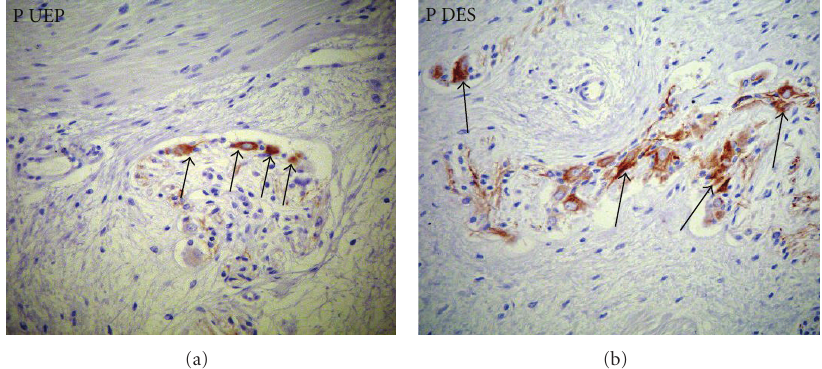
Figure 4: Peripherin (P). Immunoreactivity is less marked in the myoenteric ganglion cells of (a) the UEP than in (b) the DES.